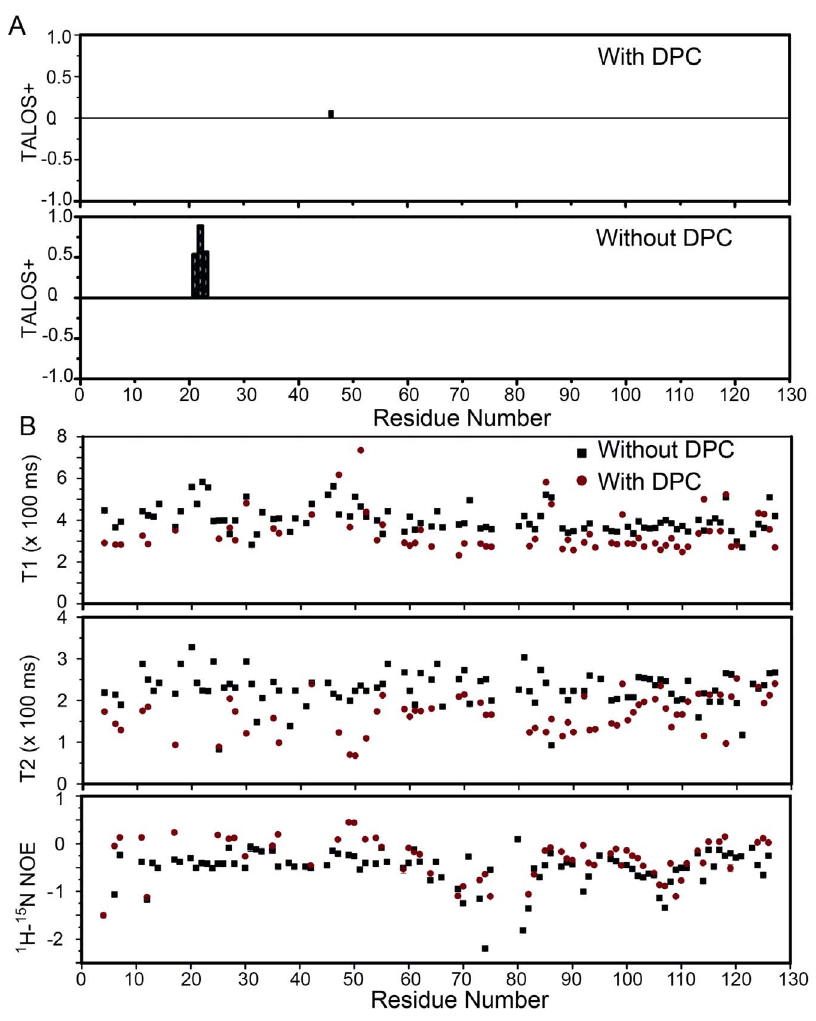
Figure 4. Secondary structure and backbone relaxation analysis of MPS-1(134–256) in the absence or presence of DPC micelles. (A) TALOS + secondary structure prediction were based on the assigned backbone 13 CO, 13 C a , 13 C b chemical shifts of MPS-1(134–256) in the presence or absence of DPC. Only random coil secondary structure was observed for MPS-1(134–256) in both aqueous buffer and DPC micelles. (See Fig. S3 in file S1 for the Y-axis scale from 0 to 0.3) (B) Distribution of the measured 15 N T 1 longitudinal and T 2 transverse relaxation times and steady-state 1 H- 15 N NOE values along the primary sequence in the absence (black) or presence (red) of DPC micelles.